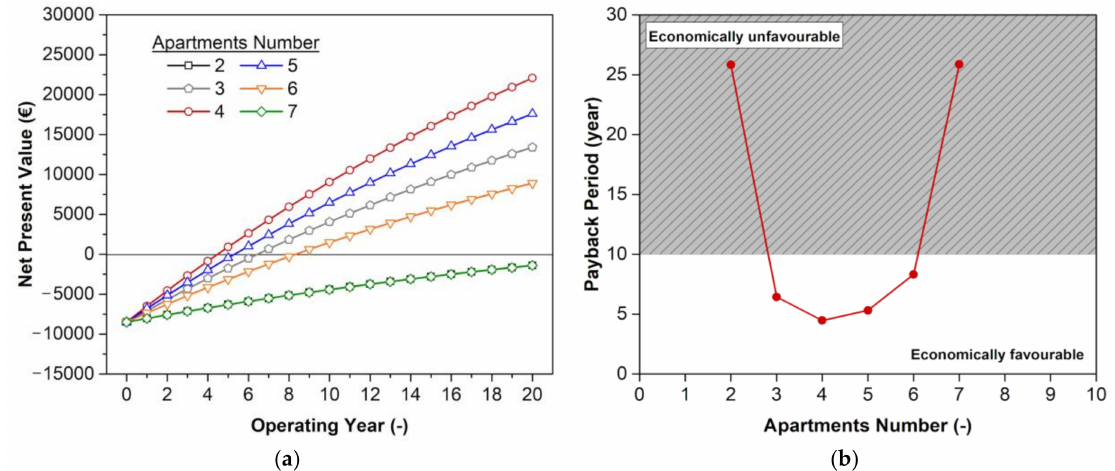
Figure 10. Influence of the number of apartments on the system’s economic feasibility: ( a ) net present values; ( b ) payback periods. Thermal-driven